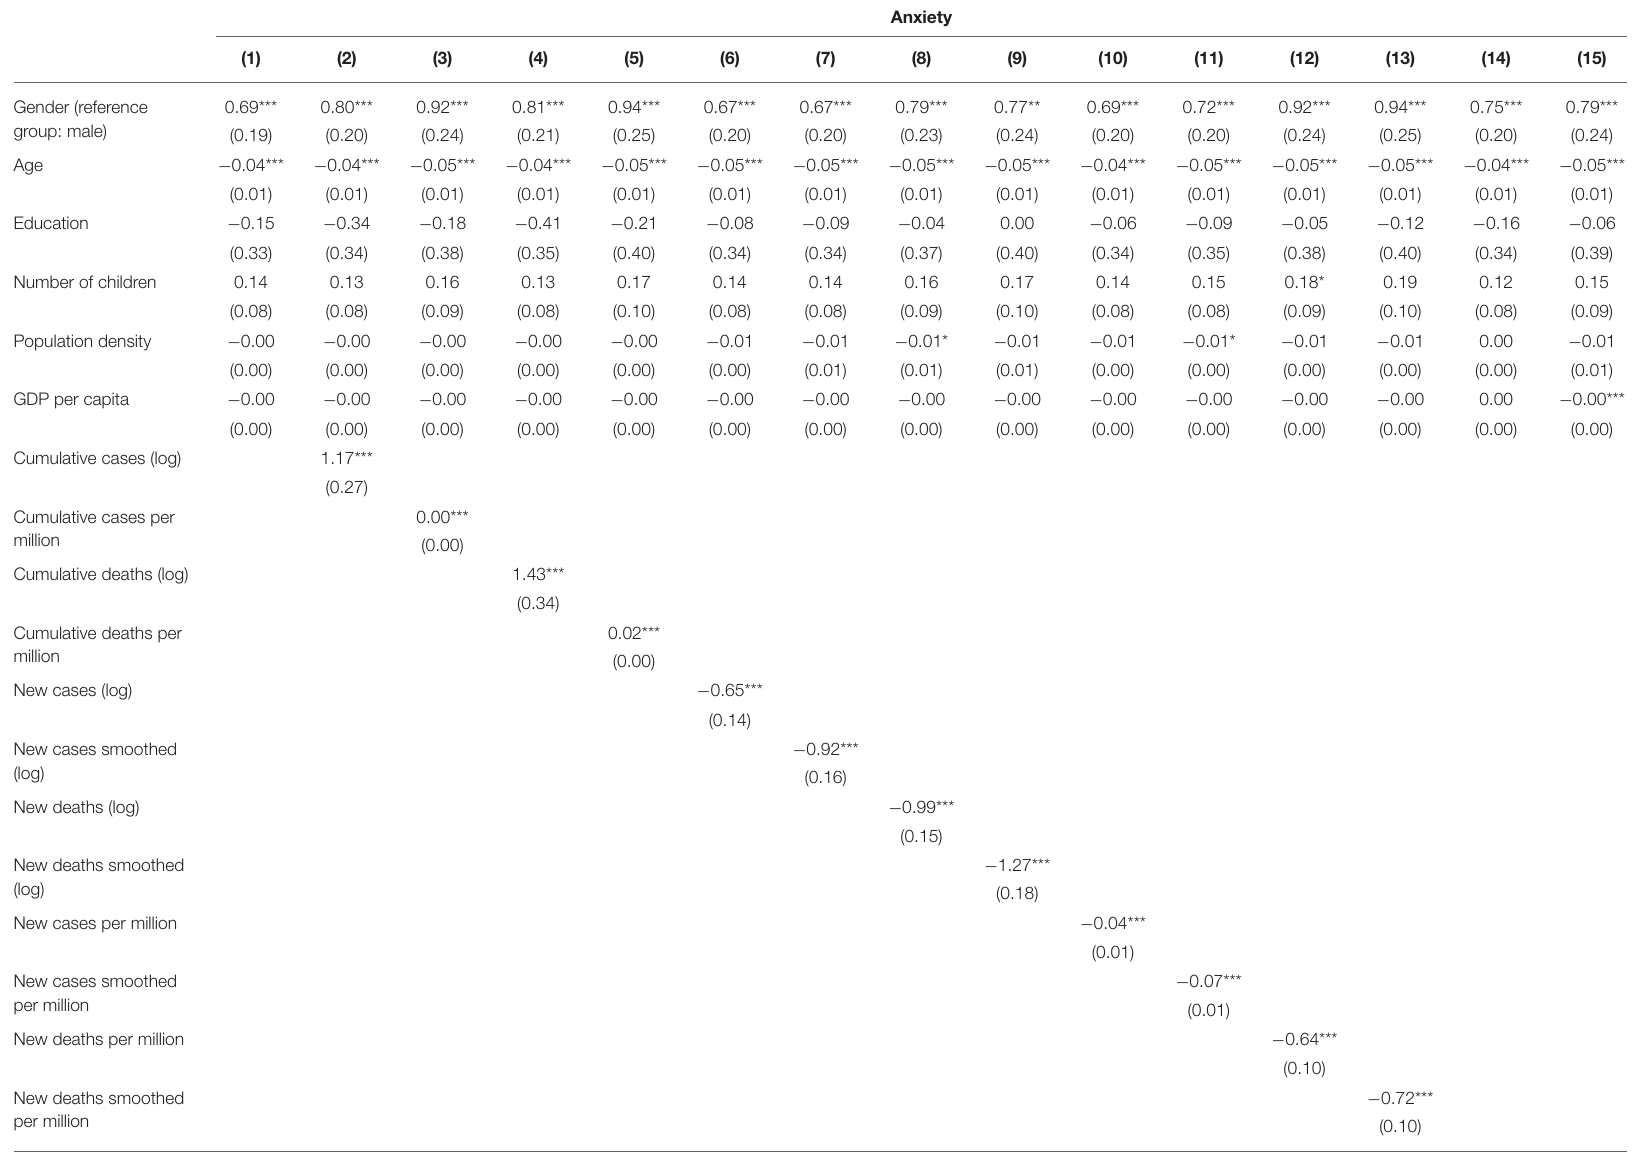
TABLE 3 | Predictors of managers’ anxiety symptoms in logistic panel regression ( n = 812, N =